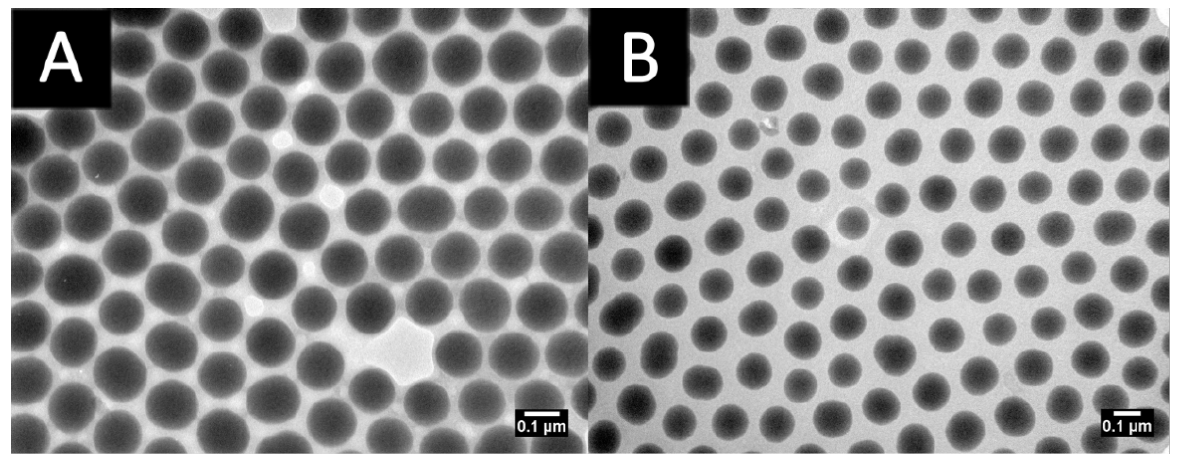
Figure 6: TEM micrographs of particles (A) after 2 hours and (B) after 21 hours of VBC polymerization. Scale bars represent 0.1 μ m.